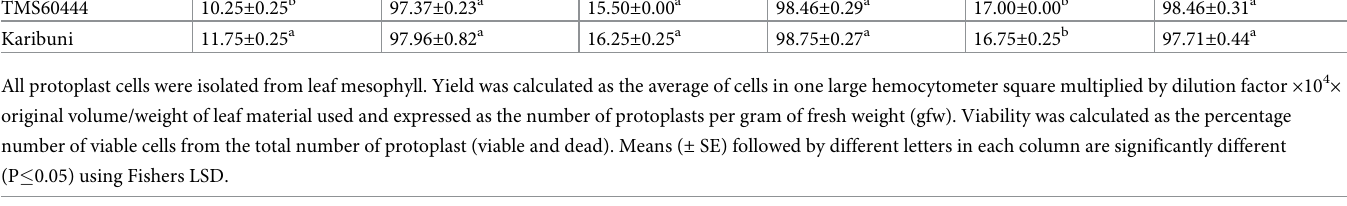
(Table 1). Muchericheri had a substantially higher response of protoplast yield with 20.50 × 10 6 protoplast/g FW. The yield of TMS60444 and Karibuni was not significantly different with change in enzyme combination. However, on close observation TMS60444 produced relatively higher number of protoplasts of 17.00 × 10 6 protoplast/g FW than Karibuni which yielded 16.75 × 10 6 protoplast/g FW (Table 1). Effects of centrifugation speed and time on protoplast purification. The separation of protoplast from digestion solution using a centrifuge with a rotor radius of 1.5cm was achieved when 1000 rpm (16 gr) was used for 10 min. In the subsequent purification process using 21% sucrose, protoplast cells could not separate from the mixture of washing solution and sucrose solution at 1000 rpm (16 gr) irrespective of increased separation time. Therefore, centrifugal speed and time were steadily increased, and at 3200 rpm (172 gr), for 15 min, viable protoplast cells were separated from dead protoplast cells (Fig 2A).